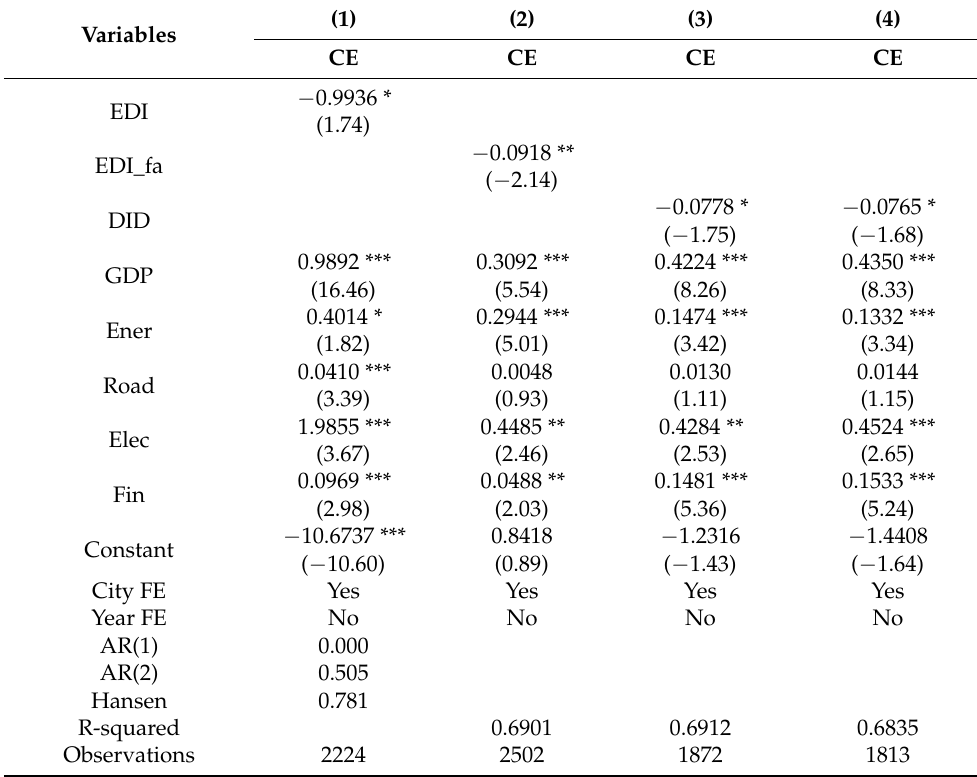
Table 8. Robustness test